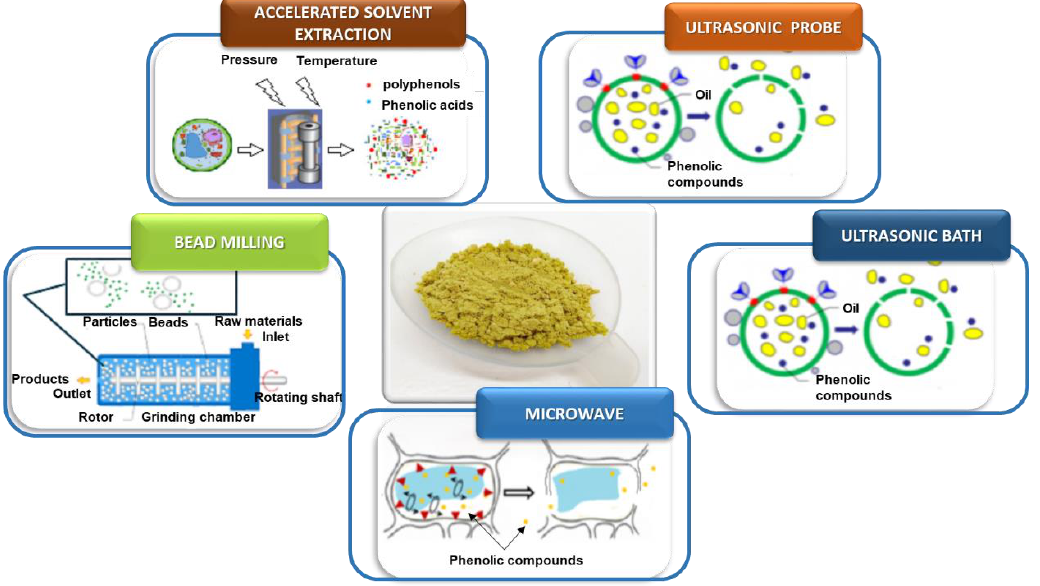
Figure 10. Effect of extraction processes on the structure of dried olive pomace powder.